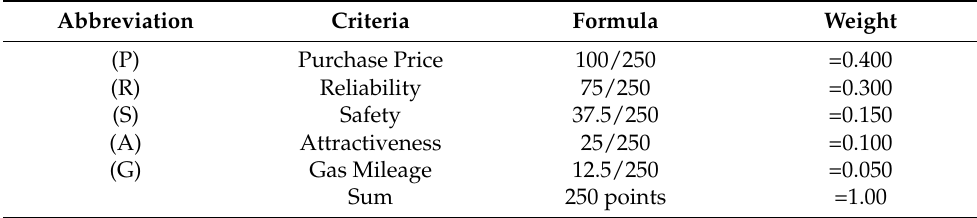
Table 7. Weight calculation for